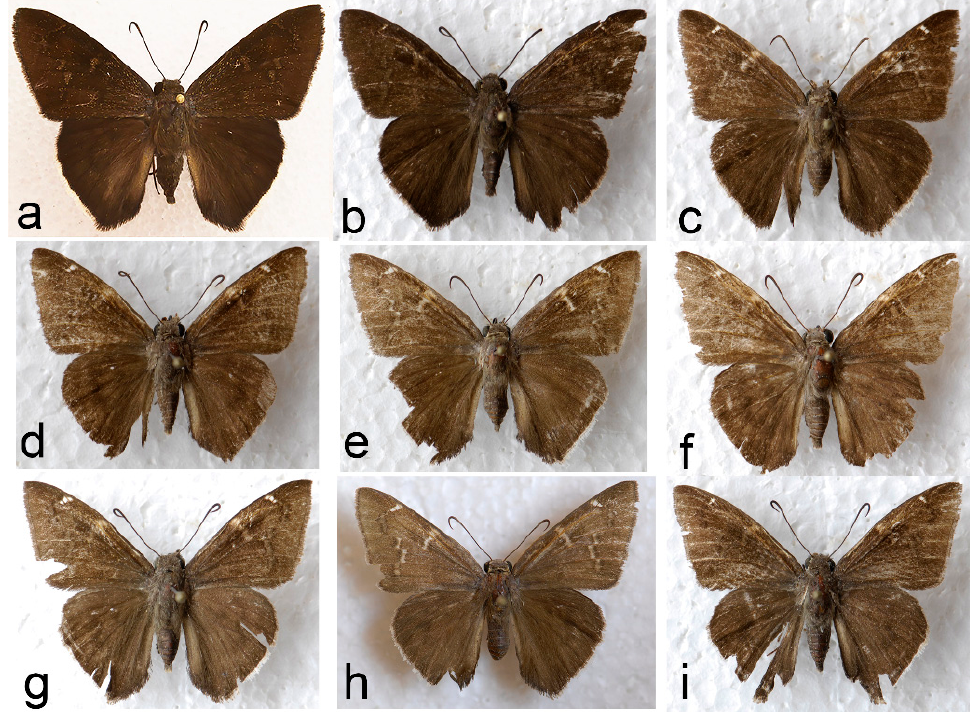
Figure 2. Photographs of Achalarus sp. cf. toxeus samples from Sonora, Mexico (dorsal surface). Wingspans are given in mm. ( a ) CIAD 14–EP11, ♂ , 47 mm; ( b ) CIAD 15–EP27, ♂ , 44 mm; ( c ) CIAD 16–EP62, ♀ , 41 mm; ( d ) CIAD 16–EP63, ♂ , 39 mm; ( e ) CIAD 16–EP64, ♀ , 46 mm; ( f ) CIAD 16–EP65, ♂ , 40 mm; ( g ) CIAD 17–EP72, ♂ , 41 mm; ( h ) CIAD 17–EP73, ♀ , 47 mm; (i) CIAD 17–EP75, ♂ , 44 mm. See Table 1 for collection data. Specimens ( a , b ) from a previous study [41] possess COI haplotype A; the remaining specimens show haplotype B (Table 1).